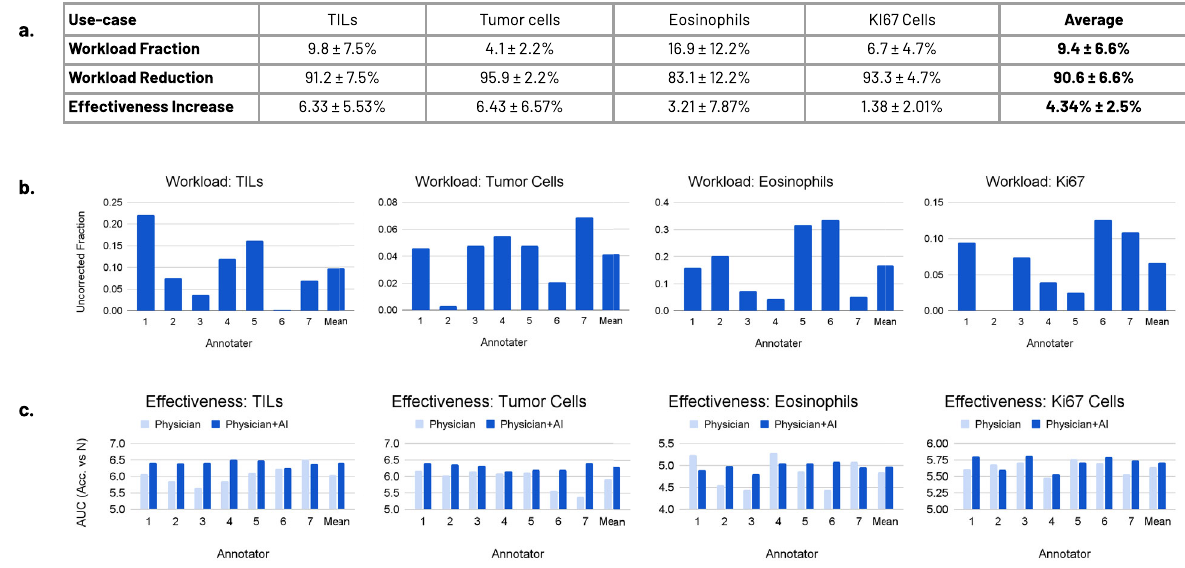
Fig. 4 Experimental results. a The average workload reduction and effectiveness increase for the four use-cases considered (TILs, tumor cells, eosinophils, and Ki-67 cells), altogether averaging a workload reduction of 90.6% and a 4.34% effectiveness improvement. Workload fraction is measured by the fraction of AI predictions changed by the annotator (0 is perfect model annotation, 1 is without an AI). Workload reduction is the inverse (1 – workload fraction). Effectiveness is measured as the area under the accuracy vs number of samples ( N ) plot, bounded by N < 200, for an AI model trained on the resultant annotated data set (see example in Fig. 5). b Workload results on the seven tested annotators – top histopathology trainees from Stanford and the University of California, San Francisco. c Effectiveness results on the same set of